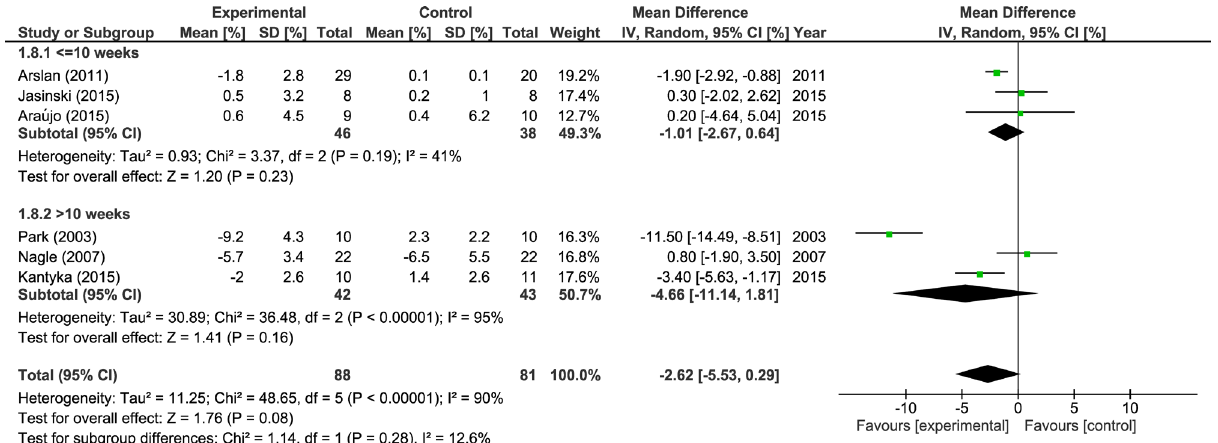
Figure 5. Assessment of the effect of aerobics on fat mass percentage depending on duration of